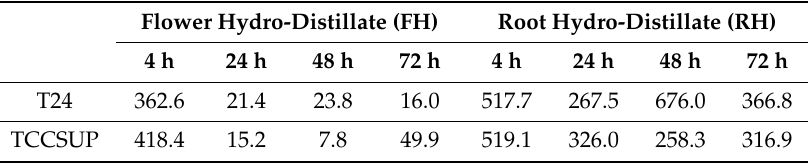
Figure 2. Percentage of metabolically active human bladder cancer cells T24 and TCCSUP after 4, 24, 48, and 72 hours of incubation with different concentrations of B. erucago hydro-distillate from the flower and roots tested. Table 4. Cytotoxic activity of volatile isolates from Bunias erucago against two human bladder cancer cell lines (T24, TCCSUP) expressed as IC 50 values ( µ